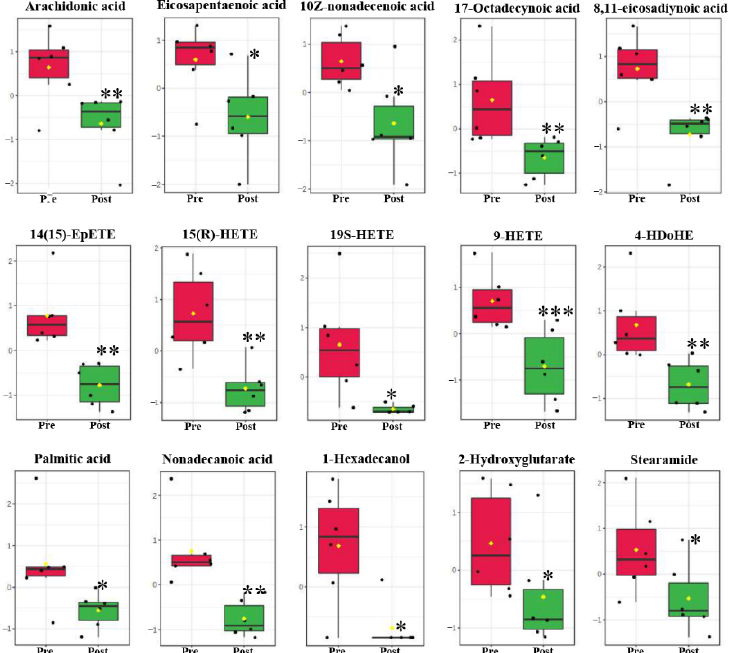
Figure 4. Significantly changed fatty acids between pre- and post-pubertal molting groups. First 10 fatty acids are unsaturated fatty acids. Values are mean and standard deviation. Pre, pre-pubertal molt group. Post, post-pubertal molt group. Asterisks *, **, and *** denote significant difference at the p < 0.05, p < 0.01, and p < 0.001 levels, respectively.